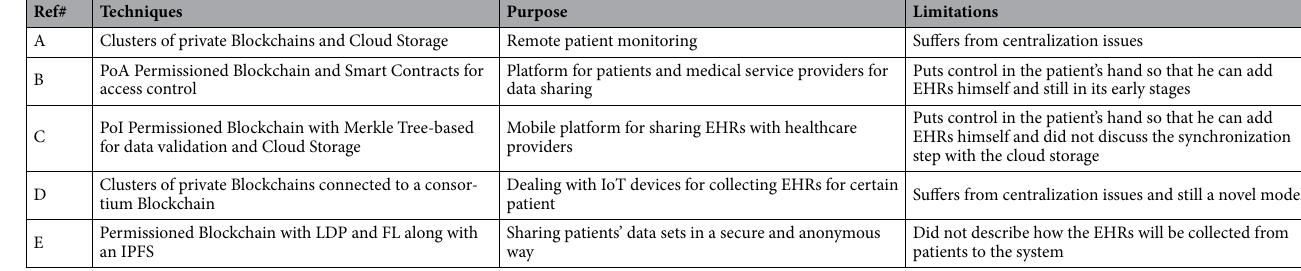
Table 1. A comparison among related work.